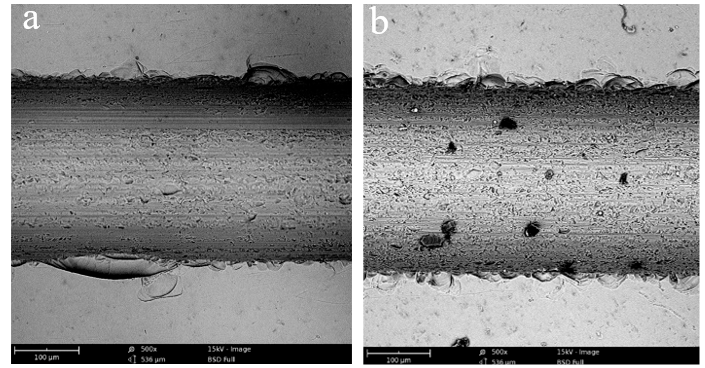
Figure 9. The morphology of edge chipping: ( a ) conventional sawing; ( b ) ultrasonic sawing.